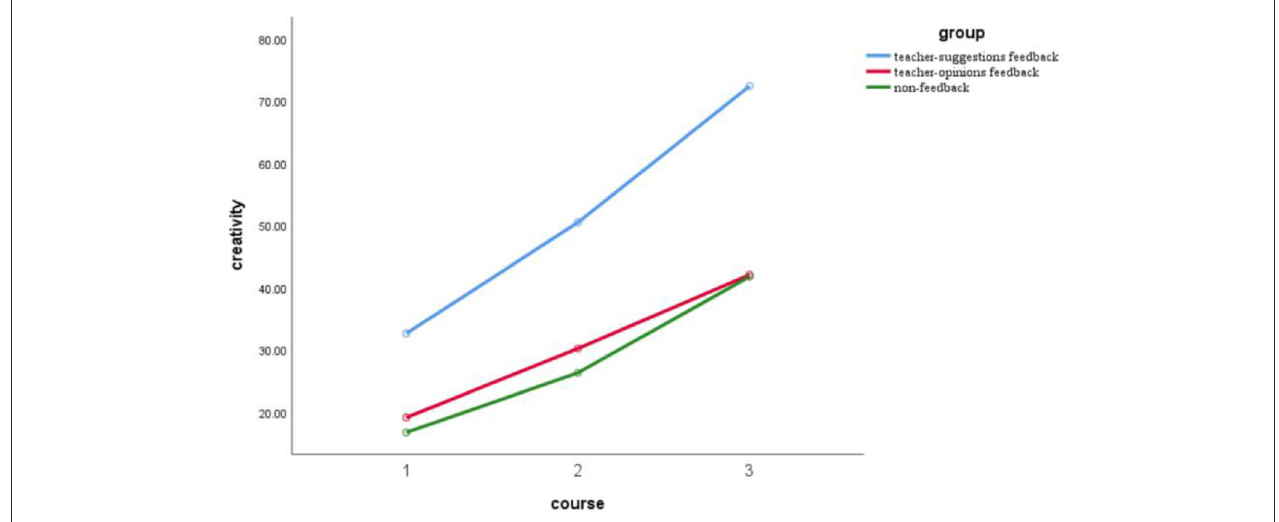
FIGURE 1 | Teacher feedback type and course time on